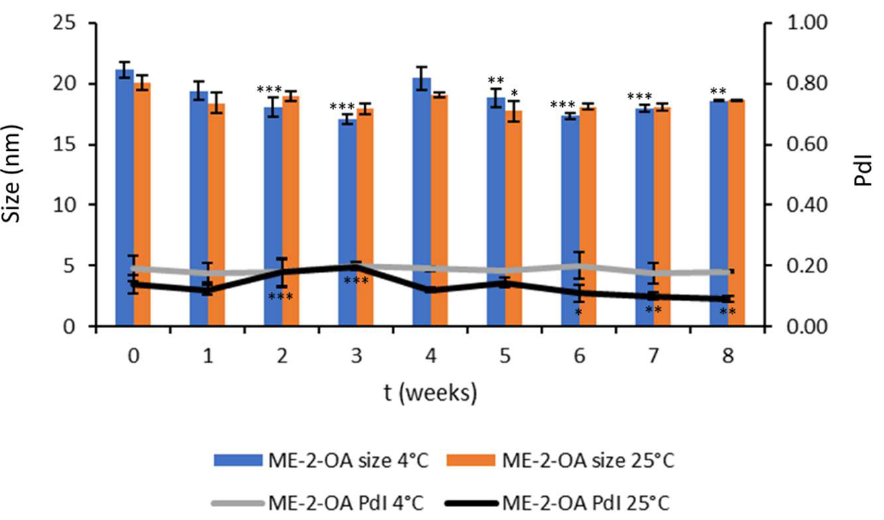
Figure 4. ME-2-OA storage stability study at 4 °C and 25 °C. Values are reported as mean ± SD of three independent experiments. Tukey’s test ( n = 3): * p < 0.05, ** p < 0.01, *** p < 0.001 vs. time zero.